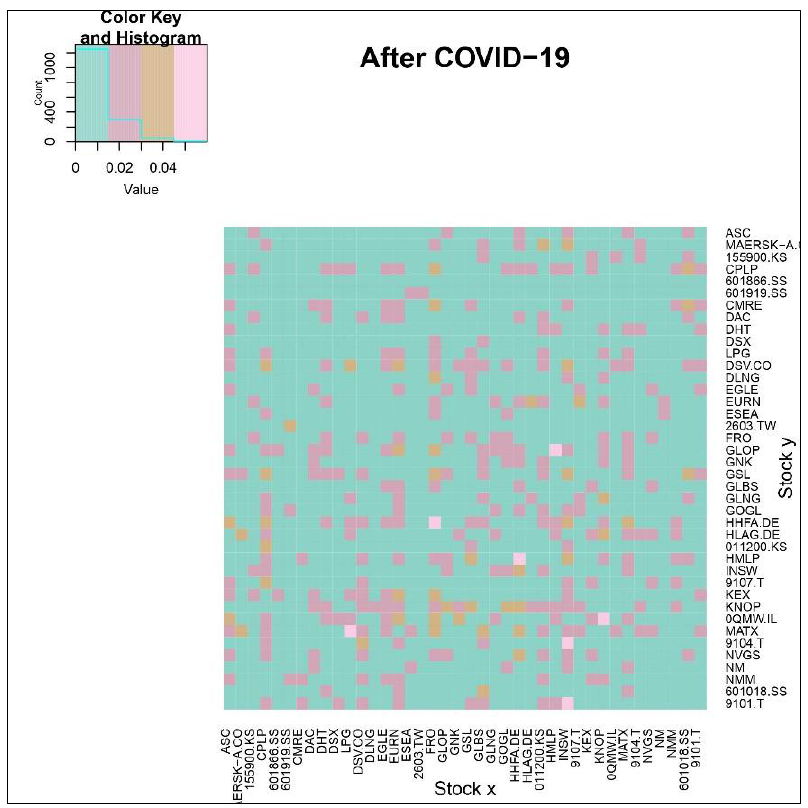
Figure 3. The information flow (effective transfer entropy) from stock y to stock x, for the companies 1 through 40 (listed in Table 1), after the COVID-19